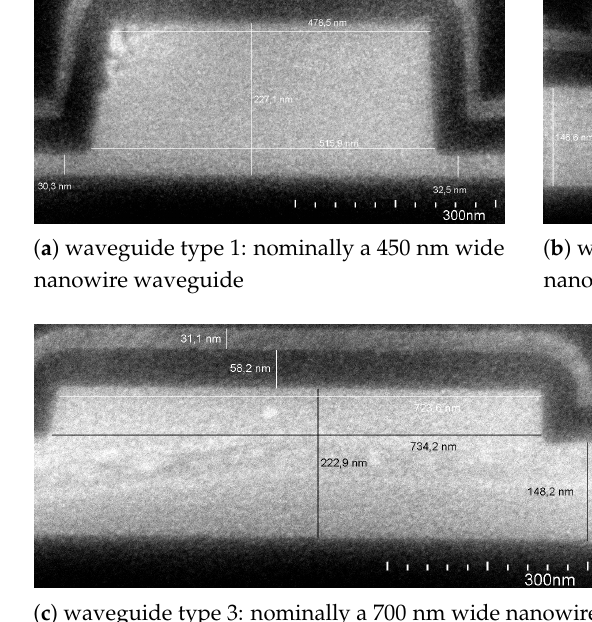
Figure 7. SEM images of the waveguide types used with the measured dimensions. Waveguides of type 1, designed as nanowire waveguides, were not etched down to the silica as planned, but still had a slab height of ≈ 31.4 nm. The waveguides showed slightly wider width compared to the design